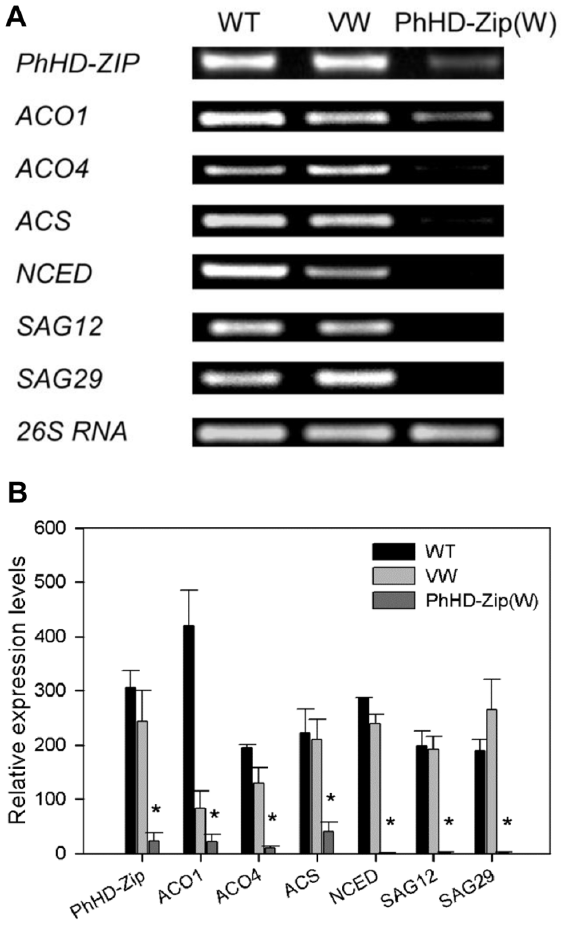
Figure 7. Expression of senescence-related genes in D7 petunia flowers. Abundance of transcripts of genes associated with senes- cence were determined at D7 in purple control flowers (WT), in white flowers of plants inoculated with the CHS /TRV reporter construct (VW), and in white flowers of plant inoculated with the PhHD-Zip / CHS /TRV silencing construct. A. A representative gel image from semi- quantitative PCR of RNA isolated from corollas. 26S RNA: the internal control. Samples were analyzed after 33 cycles for ACS, after 30 cycles for other genes, and after 24 cycles for 26S RNA , respectively. B. Relative expression levels of different genes (quantification of the gel pictures; error bars show SE of the means of three biological replicates; different letters denote significant differences using Duncan’s test at P , 0.05).